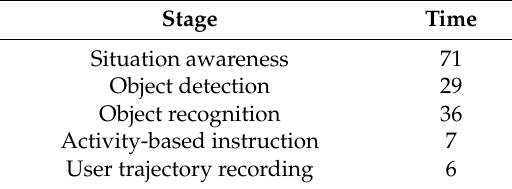
Table 6. Processing time (ms).